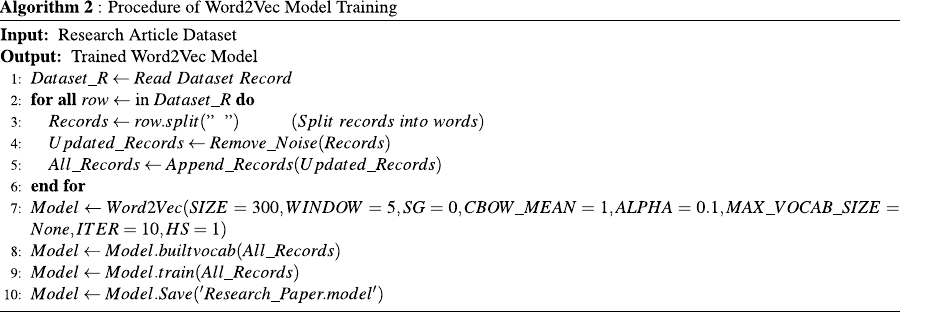
Figure 3. W2V model